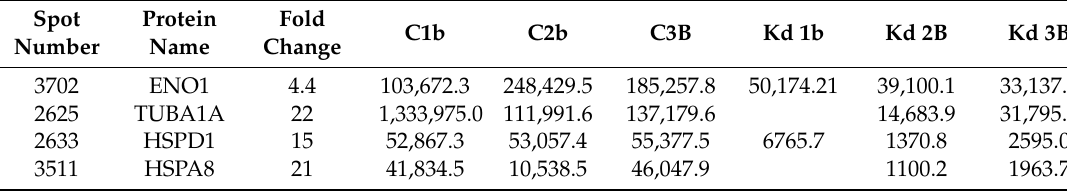
Table 1. List of differentially expressed proteins. The means of the expression of the three technical replicates are given for each of the three biological replicates. Controls (C1b, C2b, C3b) versus Knockdown (Kd1b, Kd2b, Kd3b).